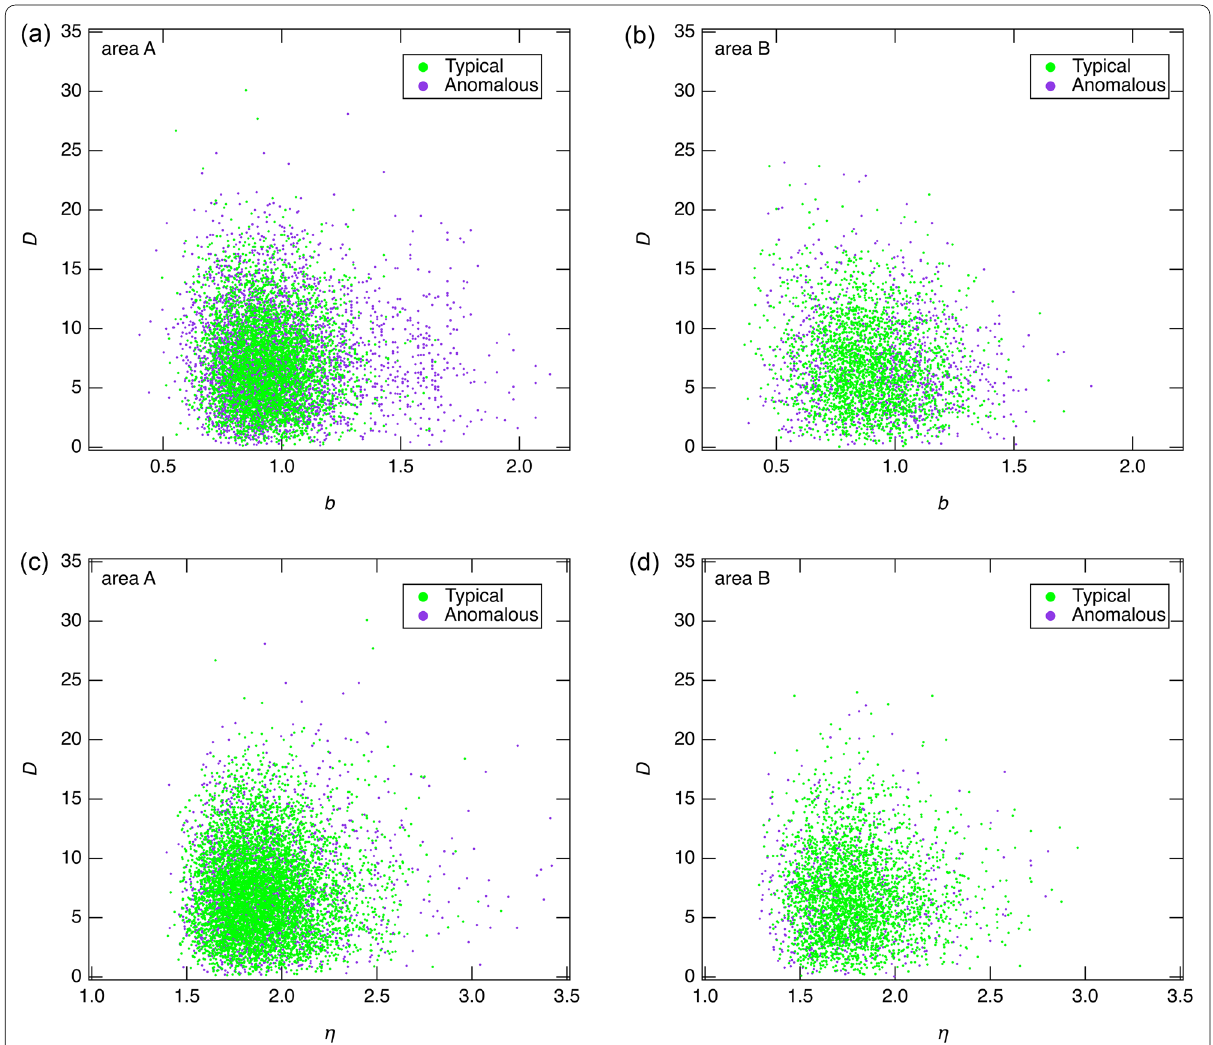
50 and l 0.4 ◦ . (Left) Area A; (right) area B. Black and gray dots indicate the cases = =